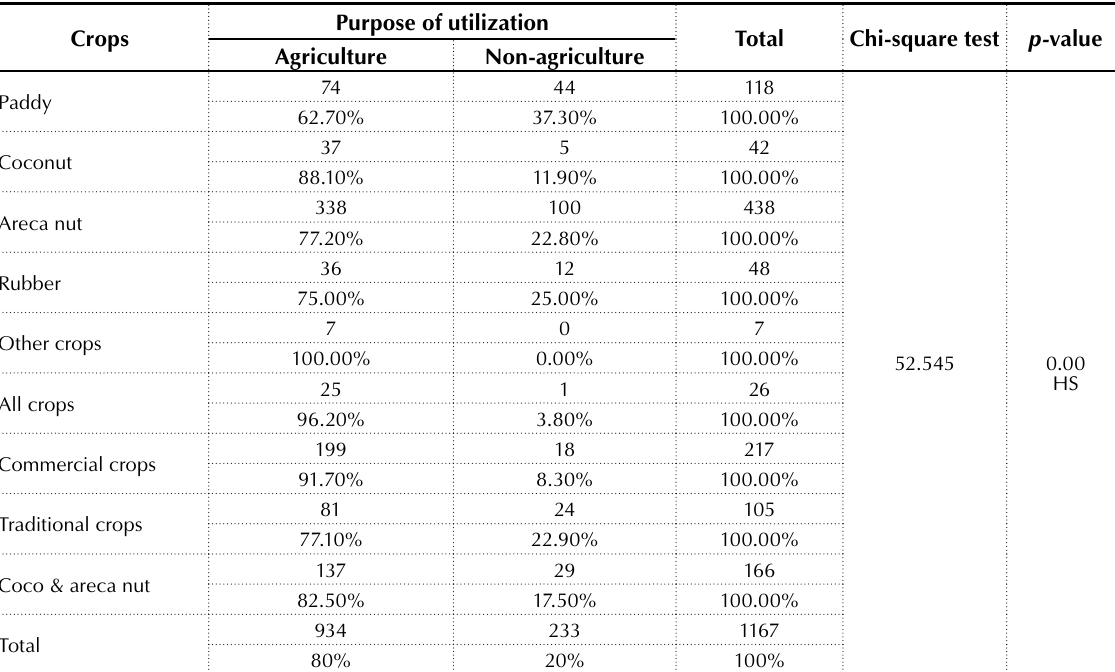
Table 10. Impact of type of crops grown on the purpose of agricultural credit utilization